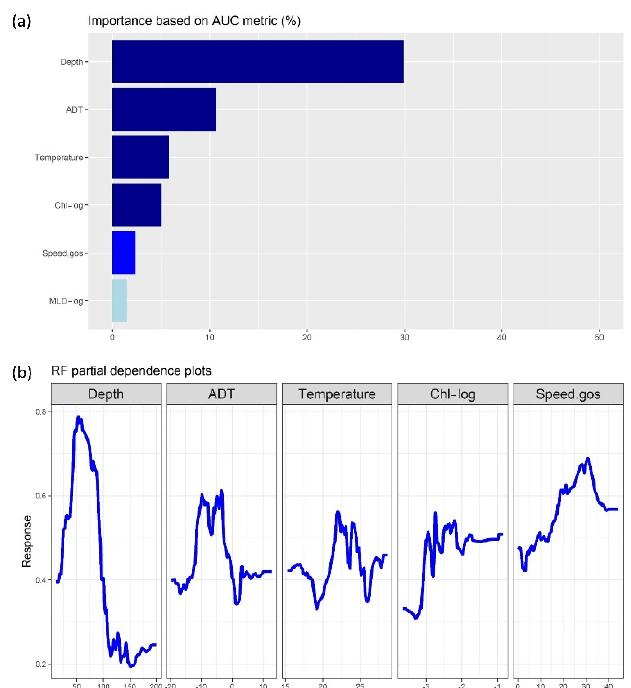
Figure 4. RF results: ( a ), barplots of variable importance scores based on AUC-metric. The dark blue, blue and light blue colored bars indicate variables with high significance ( p -value < 0.01), moderate significance (0.01 ≤ p -value < 0.05) and no significance ( p -value ≥ 0.05), respectively. ( b ), partial plots of significant ( p < 0.05) parameters are shown.